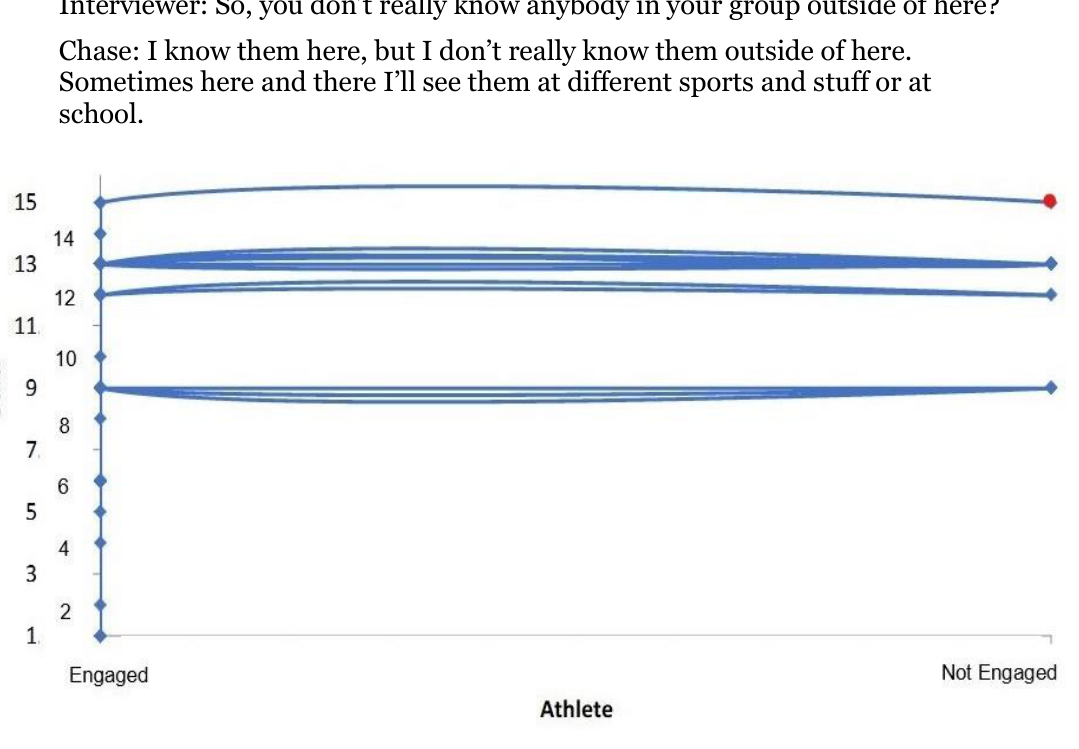
Figure 2. Behavioural sequence of the male basketball athlete comparing engagement and communication behaviours. The circle indicates the commencement of behavioural sequence. Note . 1 – Other (Athlete); 2 – Modeling (Peer); 3 – Modeling (Coach); 4 – Activity Communication